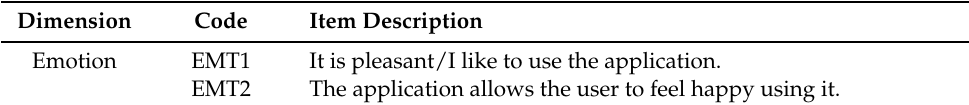
Table 2. The Emotion dimension and its